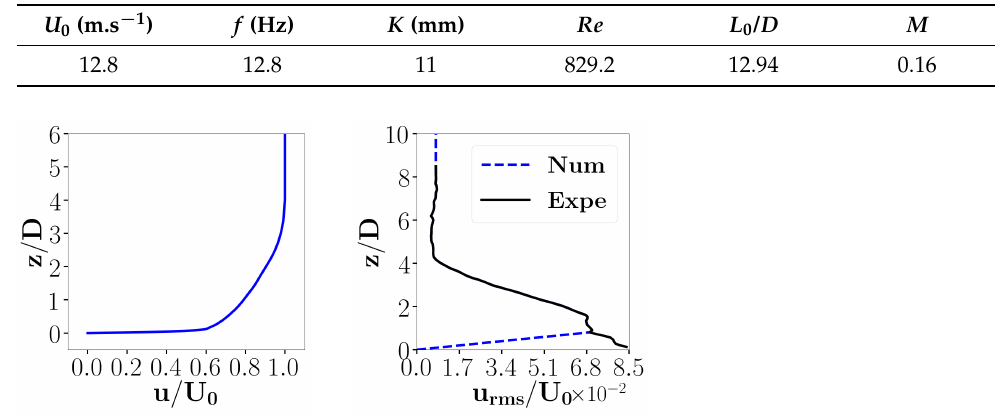
Table 1. Numerical operating points.